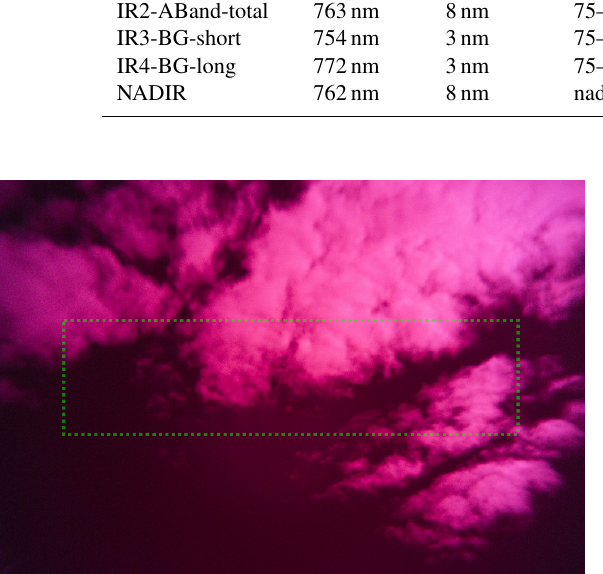
Figure 6. “First light” from a MATS instrument: ground-based pho- tograph of a cloudy sky taken with the nadir objective mounted on a Canon camera house with a full frame sensor (35mm). The dashed green rectangle denotes the cropped field of view as it will be seen with the MATS CCD